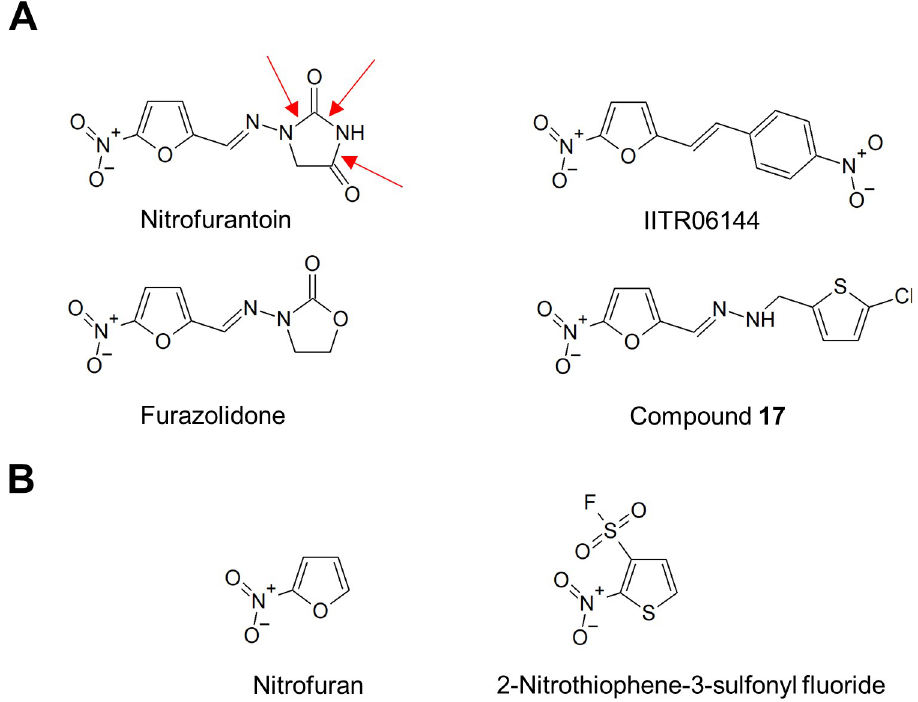
Fig 2. New nitrofuran molecules IITR06144 and compound 17 (A) and a nitroaromatic pharmacophore 2-nitrothiophene-3-sulfonyl fluoride (B) . Red arrows indicate the amide bonds of nitrofurantoin that are hypothetically hydrolyzed by the CTX-M-14 triple mutant